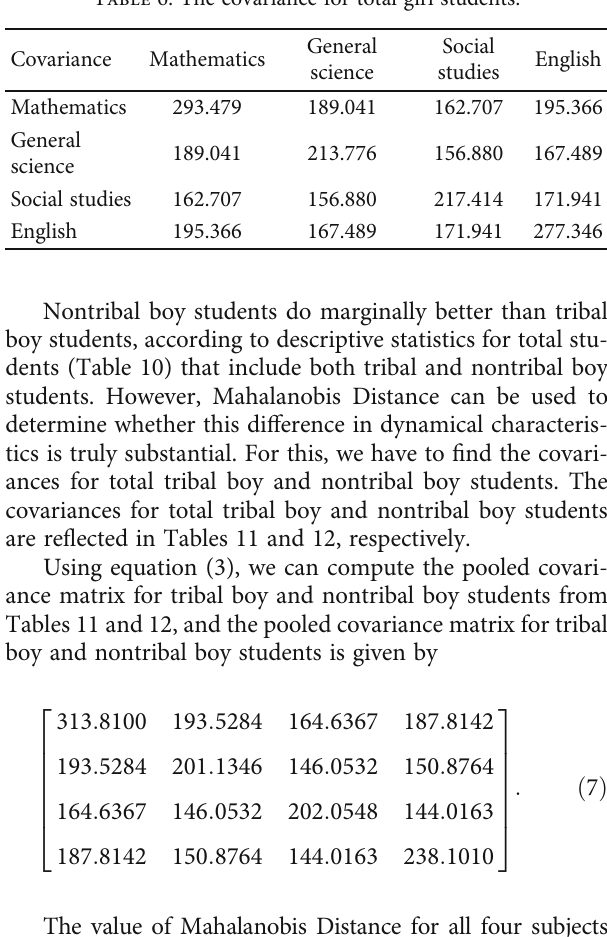
Table 6: The covariance for total girl